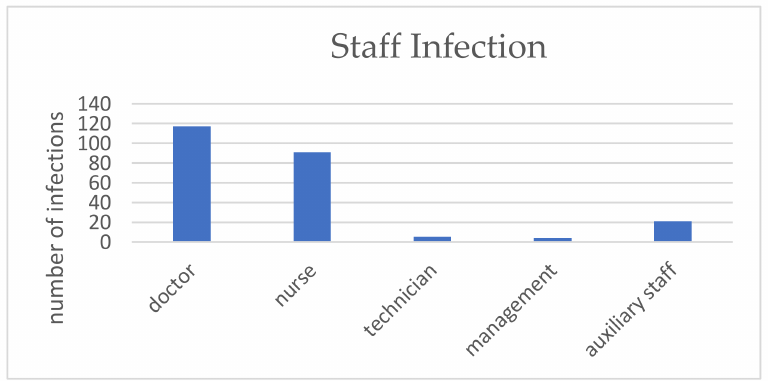
Figure 5. COVID-19 positive staff category.